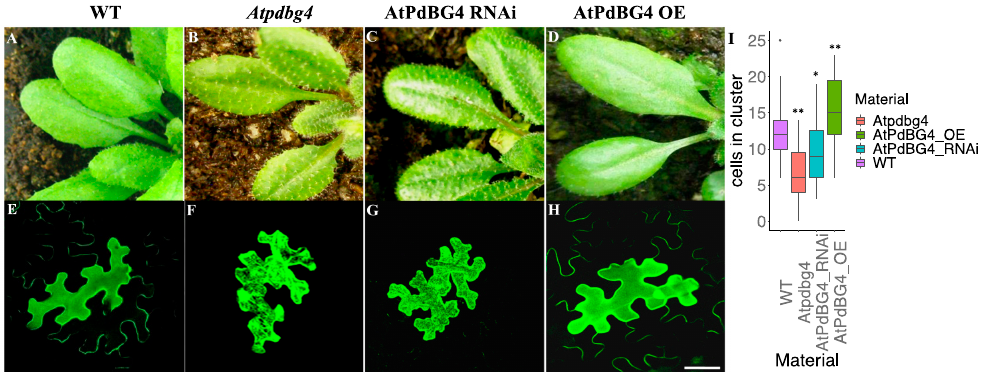
Figure 3. The phenotype of AtPdBG4 transgenic Arabidopsis thaliana and diffusion of free GFP in leaf epidermal cells. ( A – D ) Silencing and overexpression of AtPdBG4 in A. thaliana changed the phenotype of leaf trichomes. ( E – H ) Extreme representative picture of transient-expressed free GFP distribution among leaf epidermal cells in WT ( E ), AtPdBG4 mutant ( F ), RNAi transgenic ( G ), and OE transgenic ( H ) Arabidopsis thaliana epidermal cells. Bar = 30 µm. ( I ) Boxplot diagram of GFP cluster sizes in WT, Atpdbg4 , AtPdBG4 RNAi, and AtPdBG4 OE materials (determined by the number of cells in the cluster) 48 h after bombardment. The boxplot shows that the line in the middle of the box is the median value, and the median values of the WT, Atpdbg4 , AtPdBG4 RNAi, and AtPdBG4 OE materials are 12, 6, 9, and 15, respectively. The statistical analysis was performed using one-way ANOVA based on R. * indicates p < 0.05; ** indicates p < 0.01.